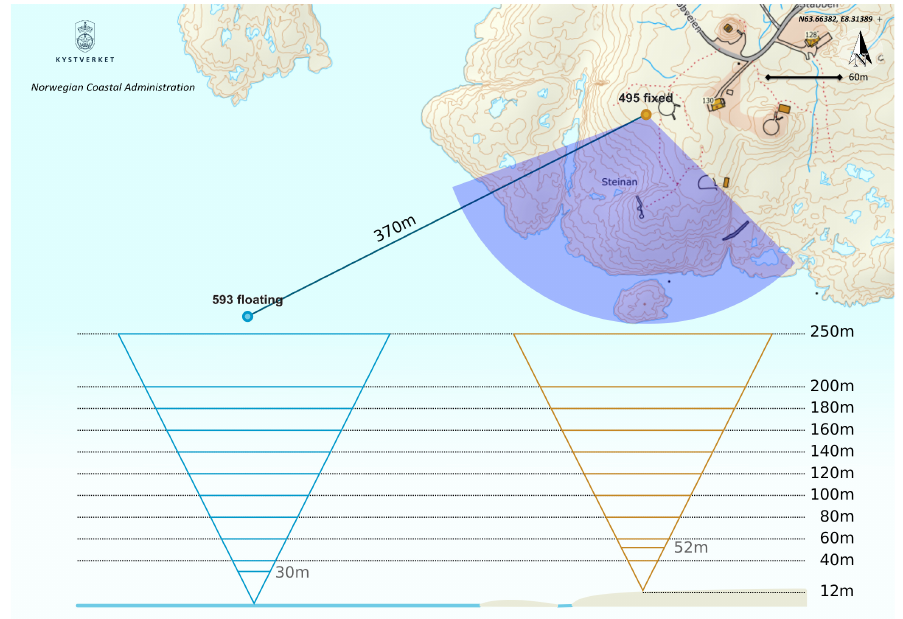
Figure 6. Map indicating the location of the floating lidar unit 593 and the land-based fixed reference lidar unit 495. The elevation difference above sea level and the geometry of the measurement cones is shown for all measurement heights. The selected offshore wind sector [ 135 ◦ ,250 ◦ ] is indicated in dark blue. (Map data adapted from